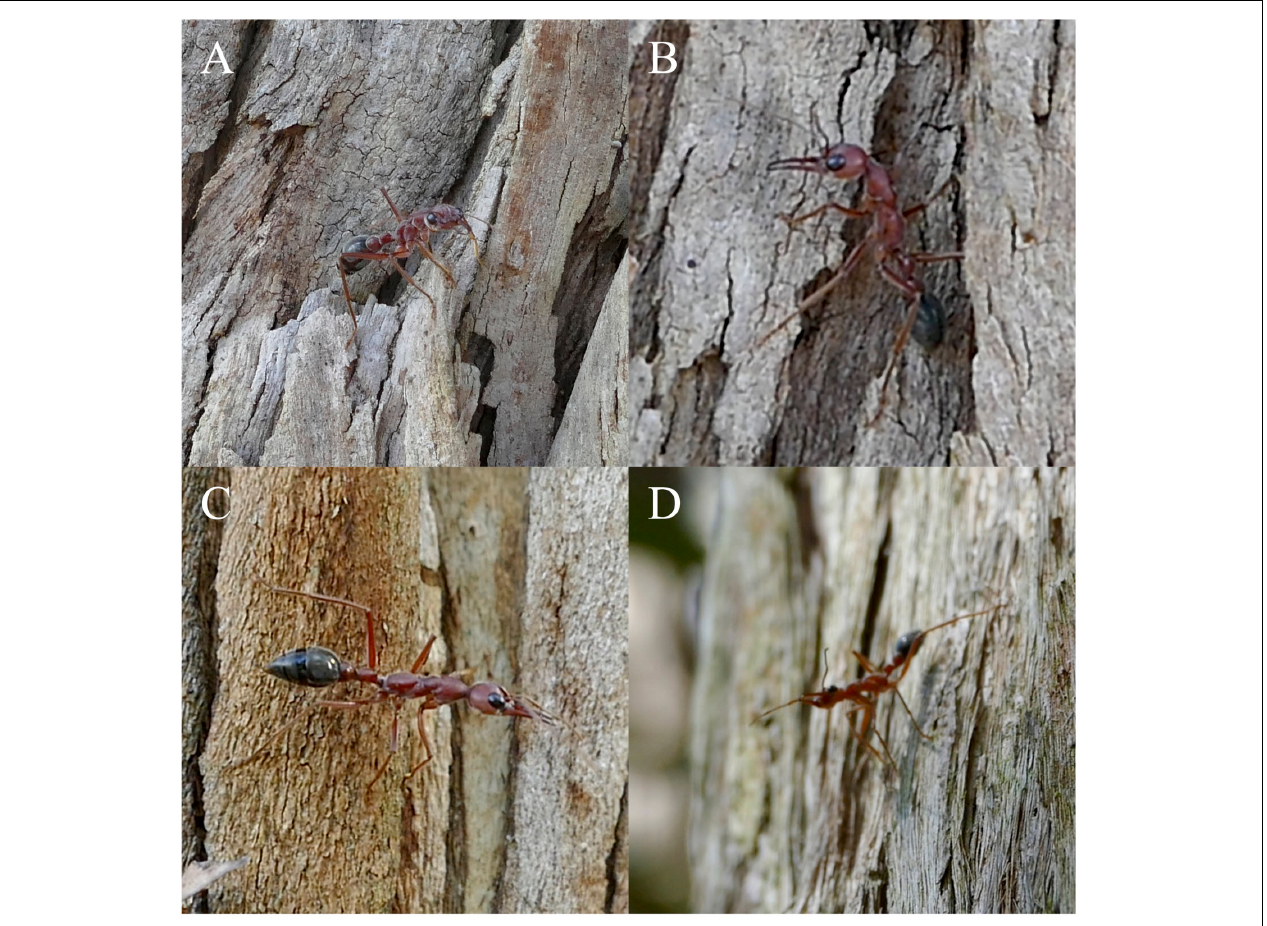
FIGURE 8 | The four described vertical scanning behaviours. All images were taken as foragers were descending their foraging tree after displacement. (A) The horizontal scan. (B) The downward pitch scan. (C) The head roll scan. (D) The push up or upward pitch